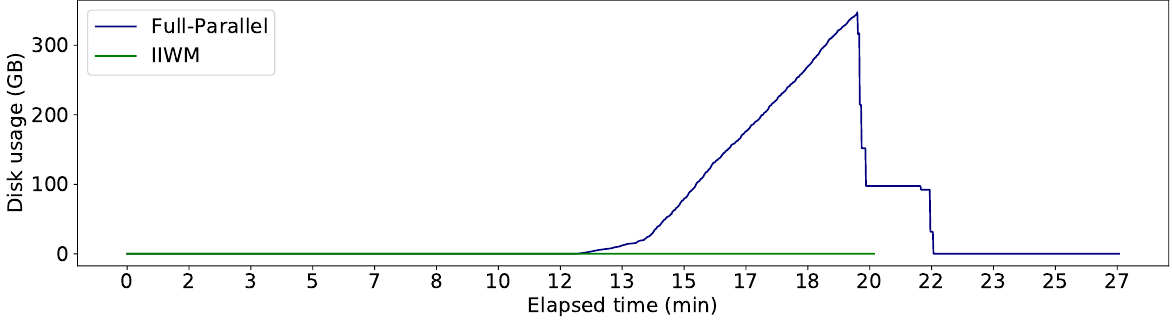
Figure 5. Disk usage over time for full-parallel and the